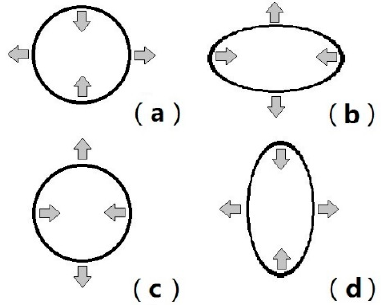
Figure 2. ( a , b , c , d ) Sequential effect of a gravitational wave on a ring of particles. In the image of Figure 2a is observed as the particles near horizontal move away from each other while those are near vertical move together to reach finally the next moment as shown in (Figure 2b). At that moment all the motions are reversed and so on. This is shown in Figure 2c,d. All these motions occur successively in the plane perpendicular (transverse) to the direction of wave propagation.